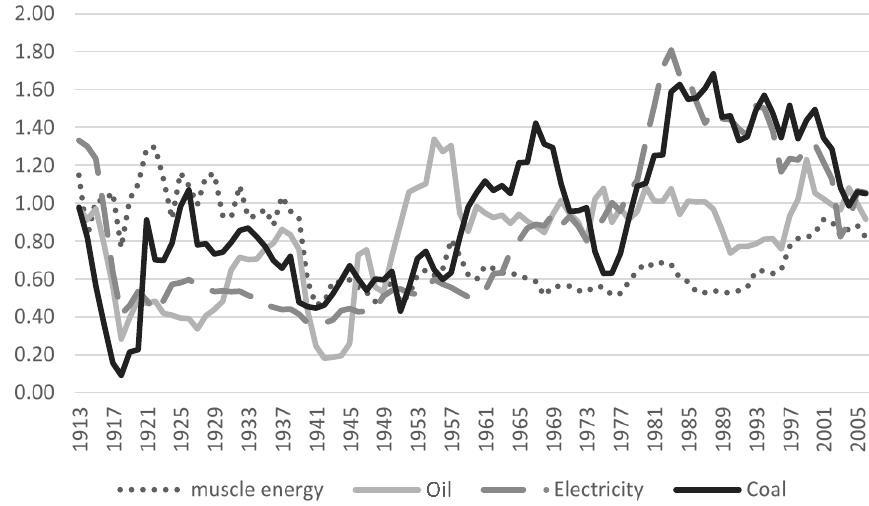
Figure 15. Ratio between nominal energy prices in Britain and Sweden. Source: Exchange rate from [19] and own